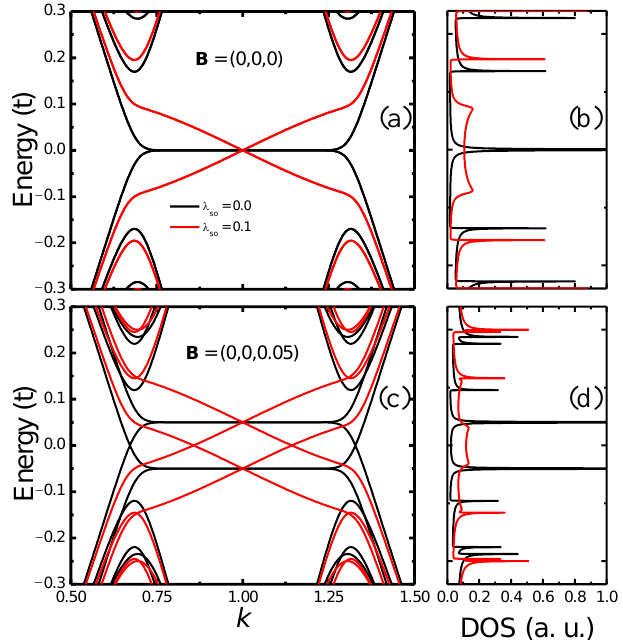
Figure 2. ( a , c ) N = 26 ZSNR energy bands, as a function of momentum, and the respective total DOS, panels ( b , d ), for energies close to the Fermi level. Panel ( a ) presents results in the absence of magnetic field for two different sets of parameters [see legend in panel ( a )], while panel ( c ) presents results for the same parameters as in panel ( a ), but with a magnetic field along the z -direction. Labels for each curve in all panels are displayed in ( a